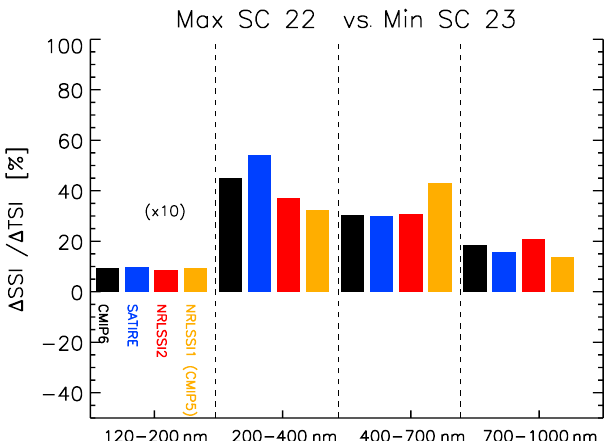
Figure 4. Contribution, in percent, of various wavelength ranges to the TSI variability between the maximum of cycle 22 and the min- imum between cycles 22 and 23. Contributions between 120 and 200nm have been multiplied by 10 for improved visibility. Maxi- mum and minimum values have been taken over an 81-day period centered on November 1989 and on November 1994,